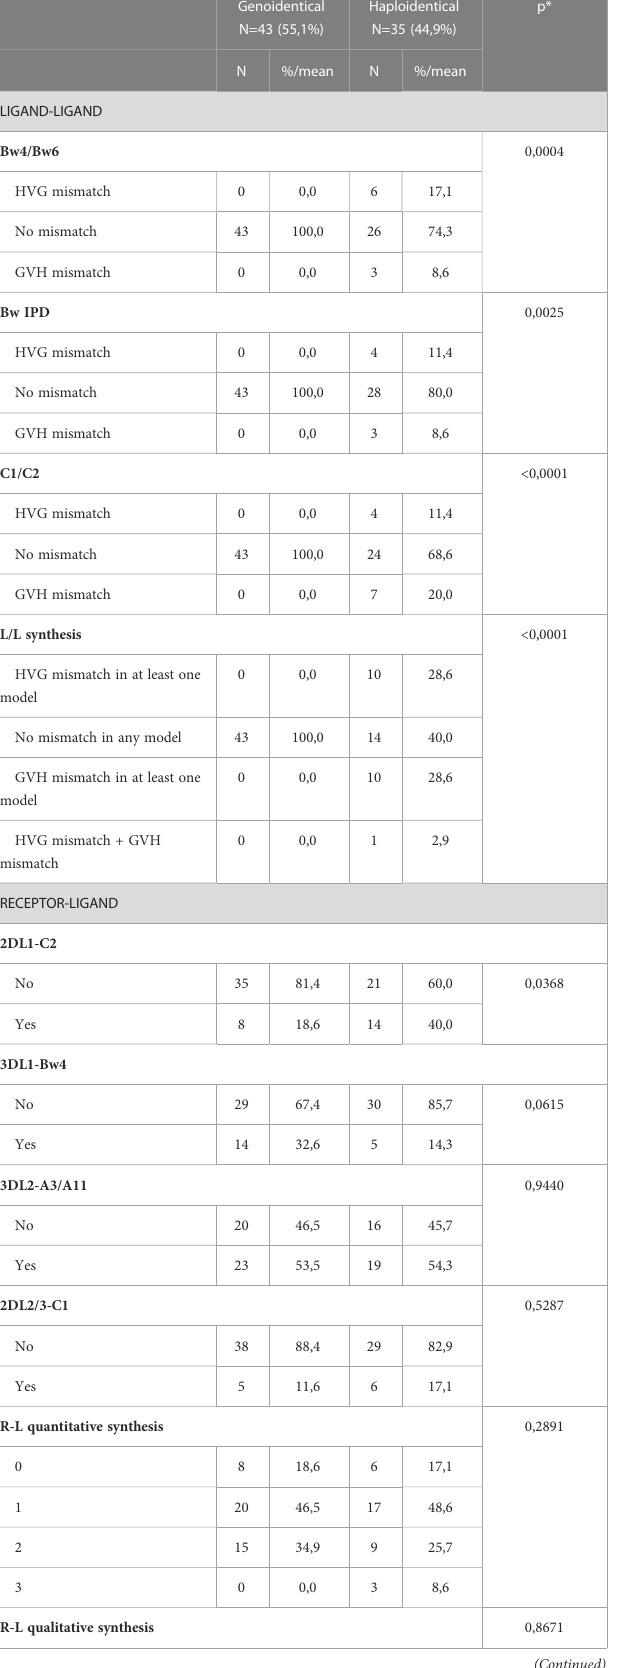
Genoidentical Haploidentical N=43 (55,1%) N=35 (44,9%)